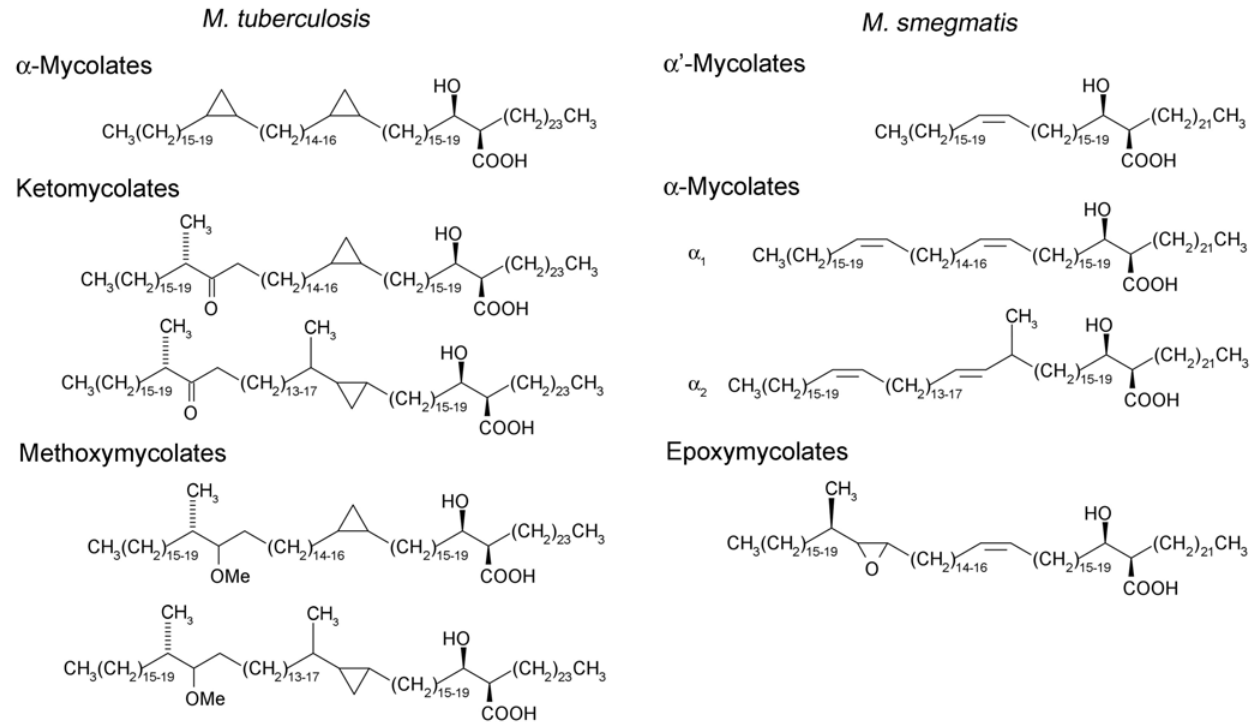
Figure 2. Structures of the major mycolic acids of M.tuberculosis and M.smegmatis .